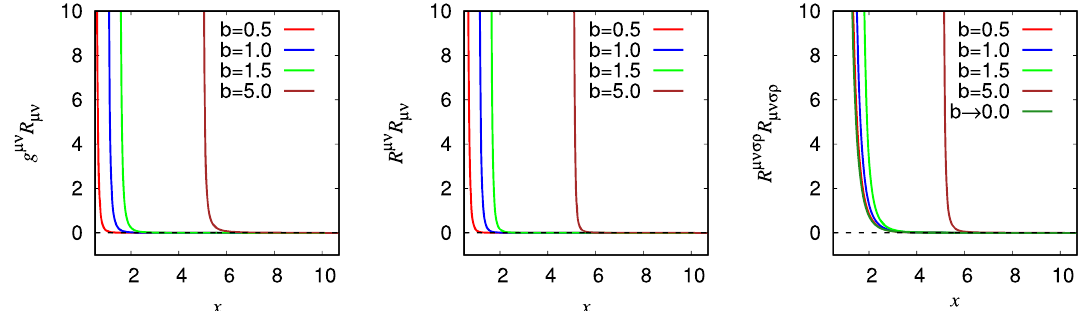
Fig. 1 TheRicciscalar,thesquareofRiccitensorandtheKretschmannscalarasafunctionoftheradius x forthequantum-correctedSchwarzschild metric